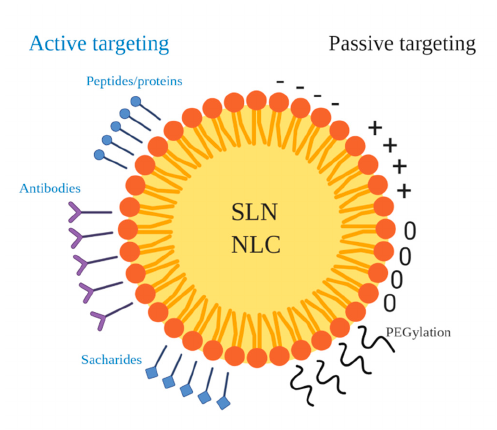
Figure 4. Examples of active and passive targeting for the functionalization of SLNs/NLCs (adapted from [101]